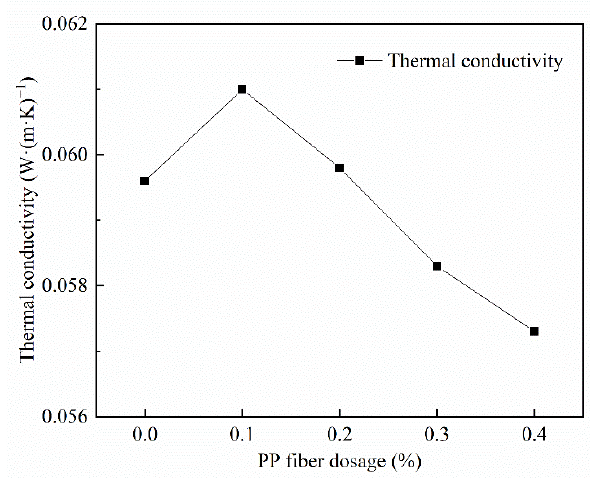
Figure 9. Influence of PP fiber dosage on thermal conductivity.